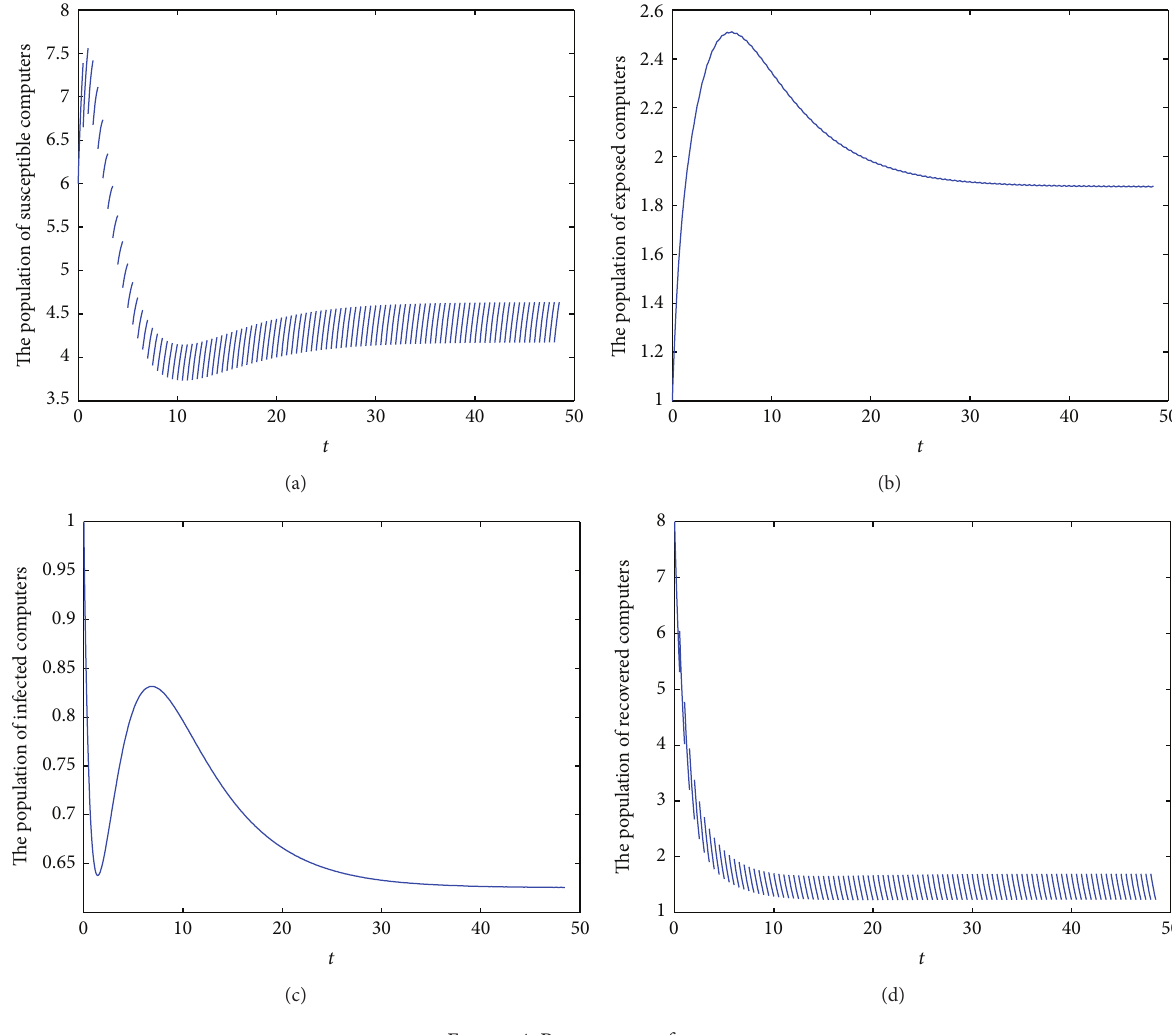
Figure 4: Permanence of